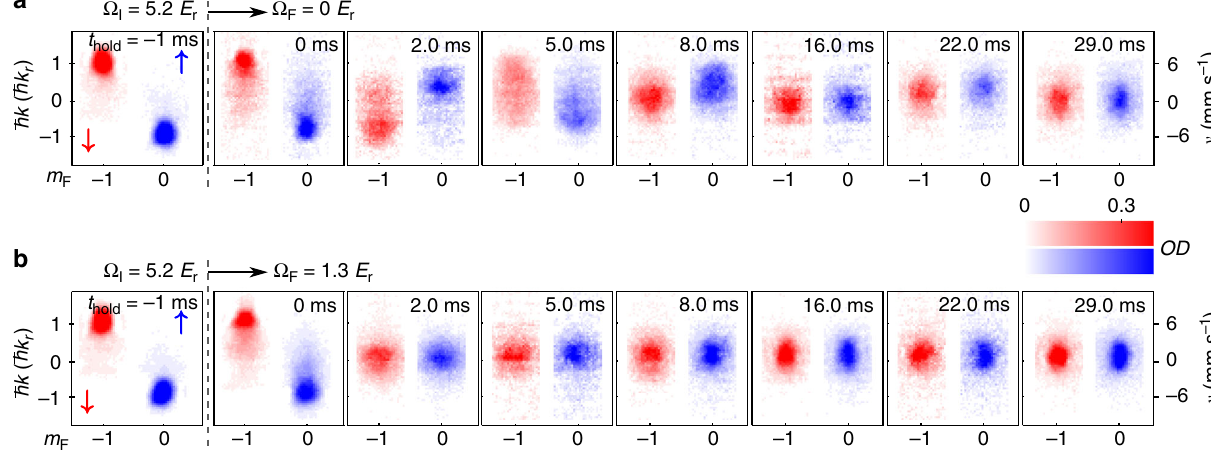
Fig. 2 SDM of a bare or a dressed BEC. Select TOF images showing the bare spin and momentum compositions of atoms taken after applying spin- dependent synthetic electric fi elds E σ with Ω F = 0 (bare BEC) in a and Ω F = 1.3 E r (SO-coupled BEC) in b , followed by various hold times ( t hold ) in the dipole trap. The TOF images labeled by t hold = − 1 ms are taken right before the application of E σ . The bare spin components (labeled by m F , with #j i in red and "j i in blue) are separated along the horizontal axis. The vertical axis shows the atoms ’ mechanical momentum ħ k along the SOC direction ^ y ð Þ . The color scale re fl ects the measured optical density ( OD , see Methods). The total condensate atom number of the initial state at Ω I is N c ~ (1 – 2) × 10 4 with trap frequencies ω z ~ 2 π × (37 ± 5) Hz and ω x ~ ω y ~ 2 π × (205 ± 15) Hz. The TOF images (and associated analyzed quantities presented later) are typically